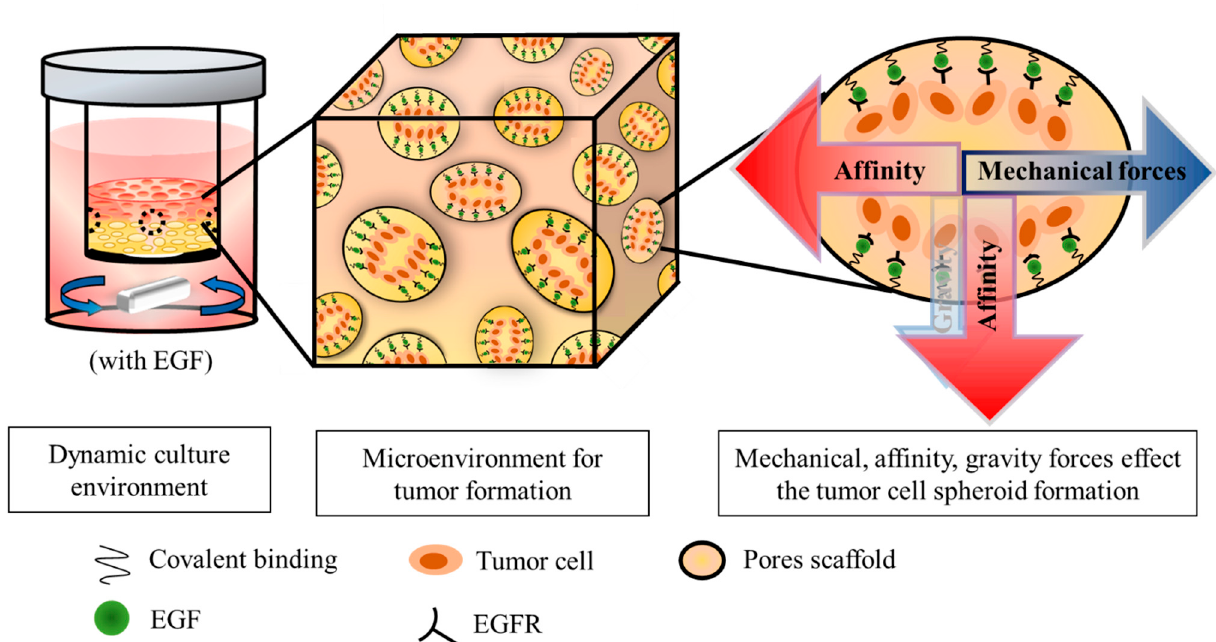
Figure 1. Schematic diagram of dynamic culture of tumor cells on GHG scaffold including immobi- lized EGF; in this way, the generated bio-affinity overcomes gravity and mechanical force to form a spheroid.